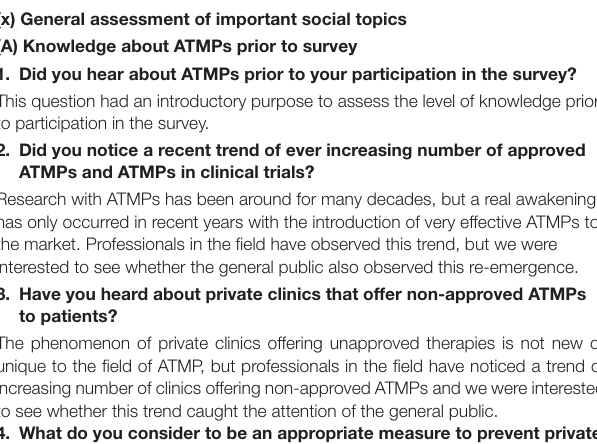
TABLE 1 | Structure and explanation of surveyed